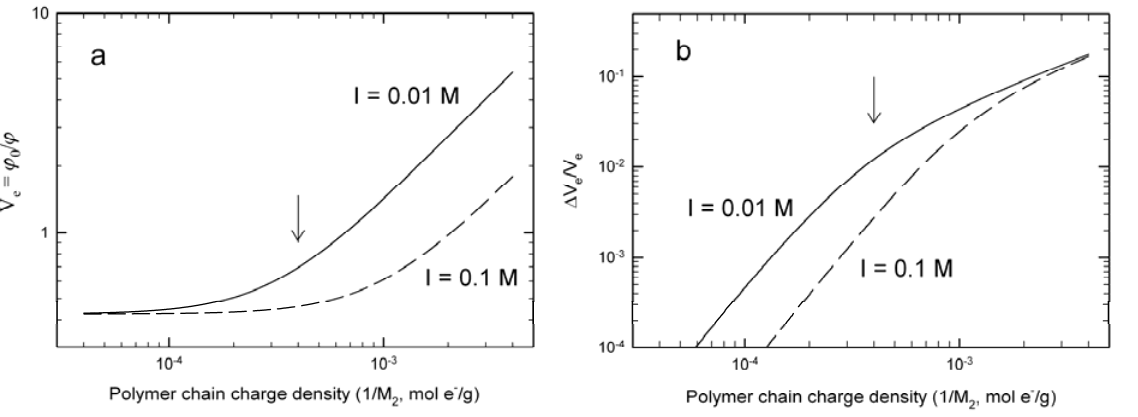
Figure 2. Example of simulation results showing the calculated equilibrium swelling ratio ) of the polymer network chains versus equivalent molecular weight per charge (M 2 (a) using Equation 2-5 for a 10% w/v hydrogel with crosslinker concentration 1 × 10 24 m -3 , = 15, and Flory Huggins interaction parameter c = 0.46, maximum stretching ratio  max ionic strength of 0.01 M and 0.1 M monovalent type salt added to the aqueous solution at a temperature of 25 ºC. The crosslink concentration of 1 × 10 24 m -3 correspond to 0.118 mol% of the crosslinker assuming the 10% w/v hydrogel is a polyacrylamide based hydrogel crosslinked with bis-acrylamide. Figure 2b depicts the relative change in swelling volume versus the equivalent molecular weight per charge of the polymer network chains for the simulation depicted in Figure 2a. The arrows (Figure 2a,b) depict ) used in the calculations in Figure the charge density (1/M 2